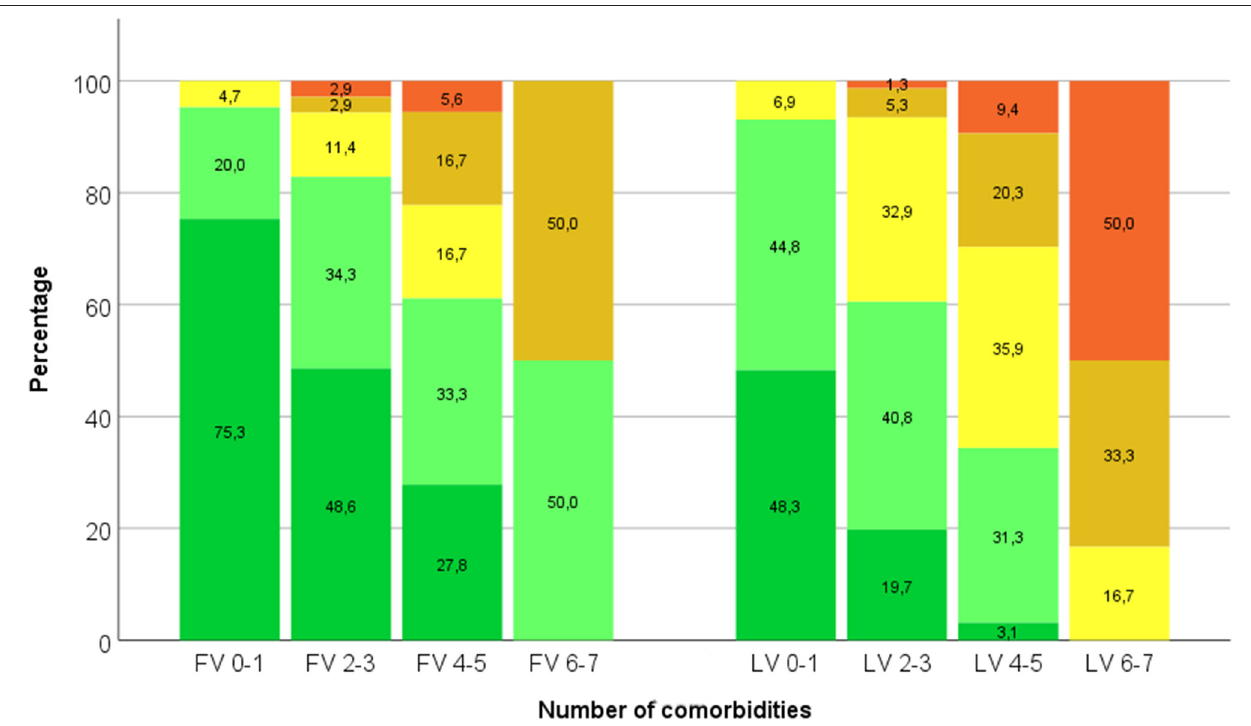
FIGURE 3 | Percentages of patients with increasing number of medications (grouped into ≤ 3—dark green–, 4–6—light green–, 7–9—yellow–, 10–12—amber–, and > 12—red–) depend on number of comorbidities (0–1, 2–3, 4–5, and 6–7) both at first visit (FV) and last visit